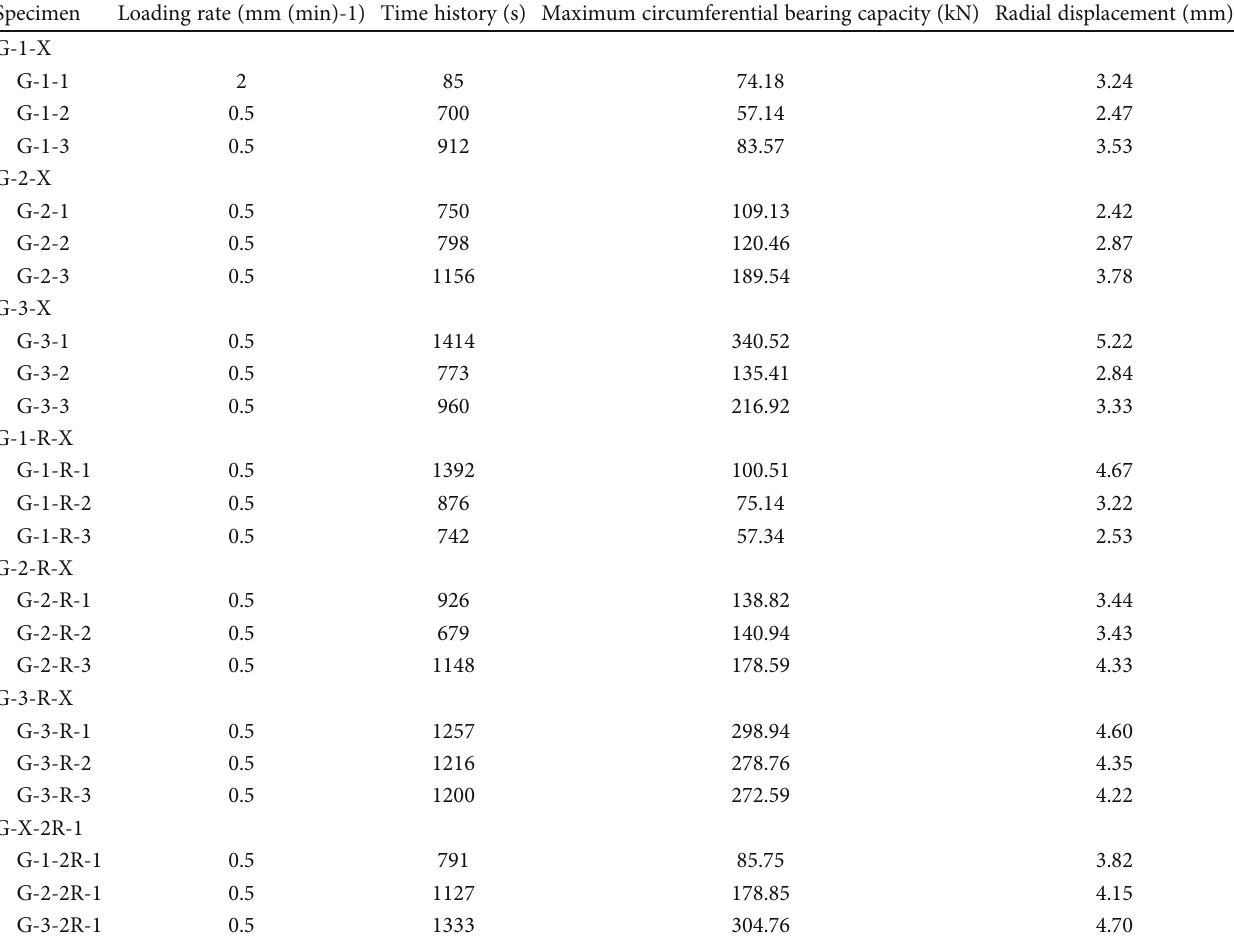
Table 2: Results of circumferential expansion